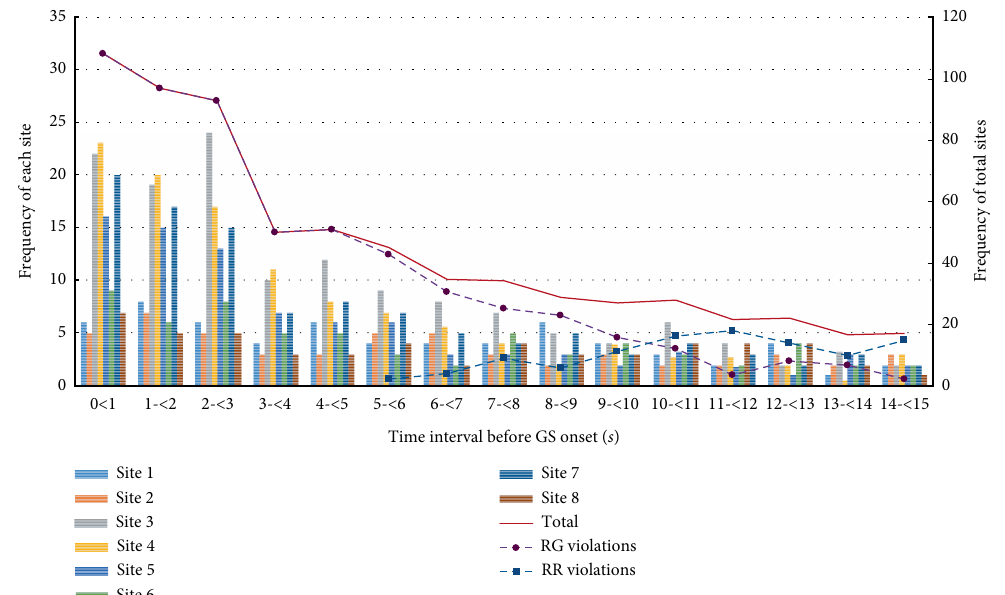
Figure 6: Crossing time distribution of RG/RR violations before GS onset.